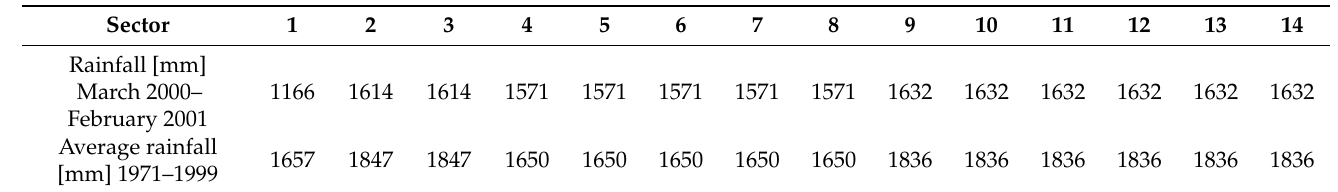
Table 2. Precipitation in the 12 months preceding the seismic events of 2001 and the average annual precipitation in 1971–1999 in the fourteen areas under